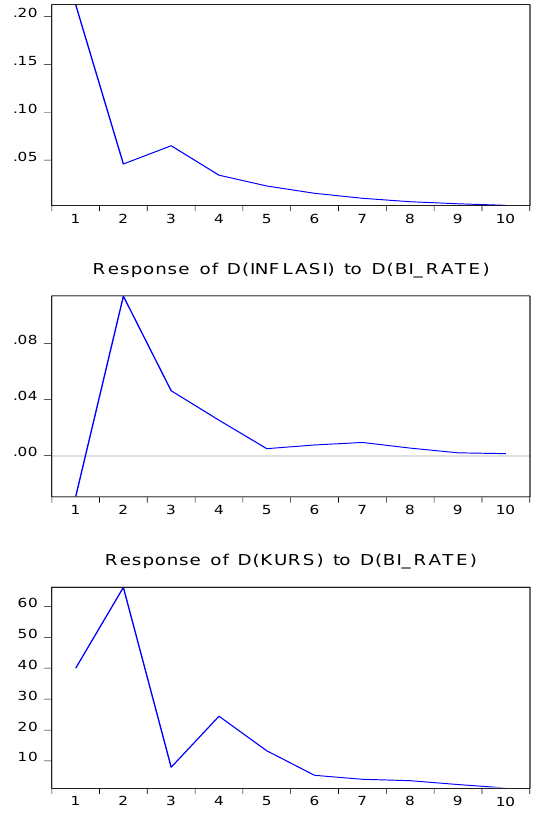
Figure 1: Impulse response interest